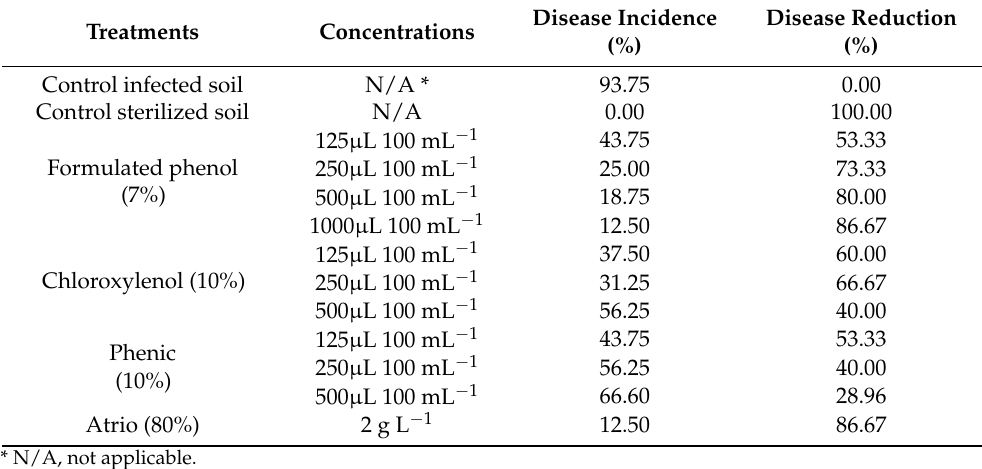
Table 6. Effect of disinfectant agents at different concentrations and atrio 80% on the incidence of tomato root rots caused by S. rolfsii at 35 DAP (greenhouse conditions).